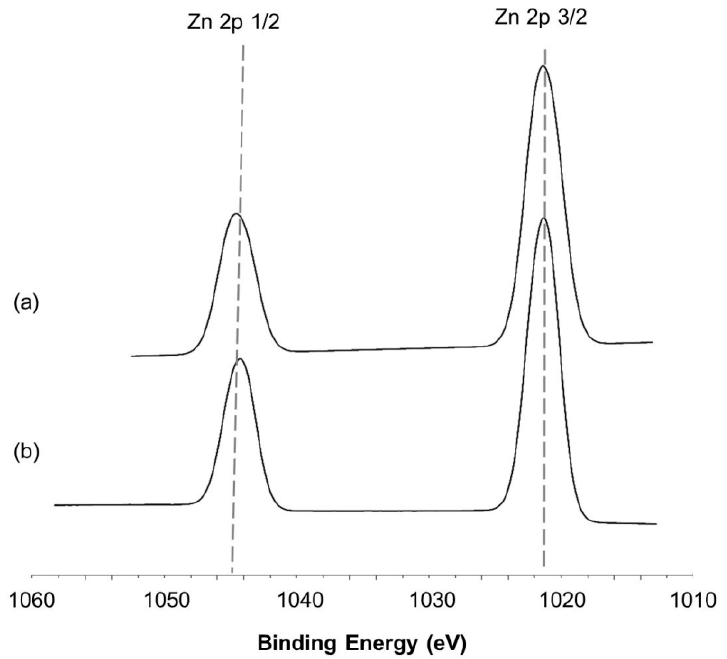
Figure 3. Zn 2p X-ray photoelectron spectroscopy (XPS) spectra of ( a ) Cu-Zn (no magnet)/CeO 2 -Al 2 O 3 (no magnet) and ( b ) Cu-Zn (N-S)/CeO 2 -Al 2 O 3 (N-N).